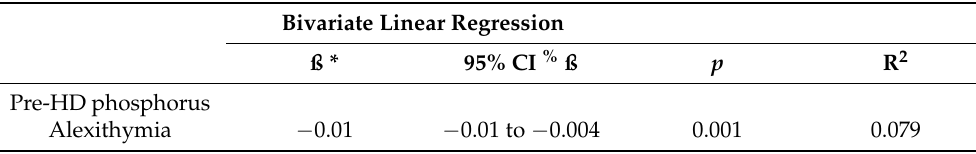
Table 9. Functional correlation of phosphorus with alexithymia (linear regression analysis). Bivariate Linear Regression